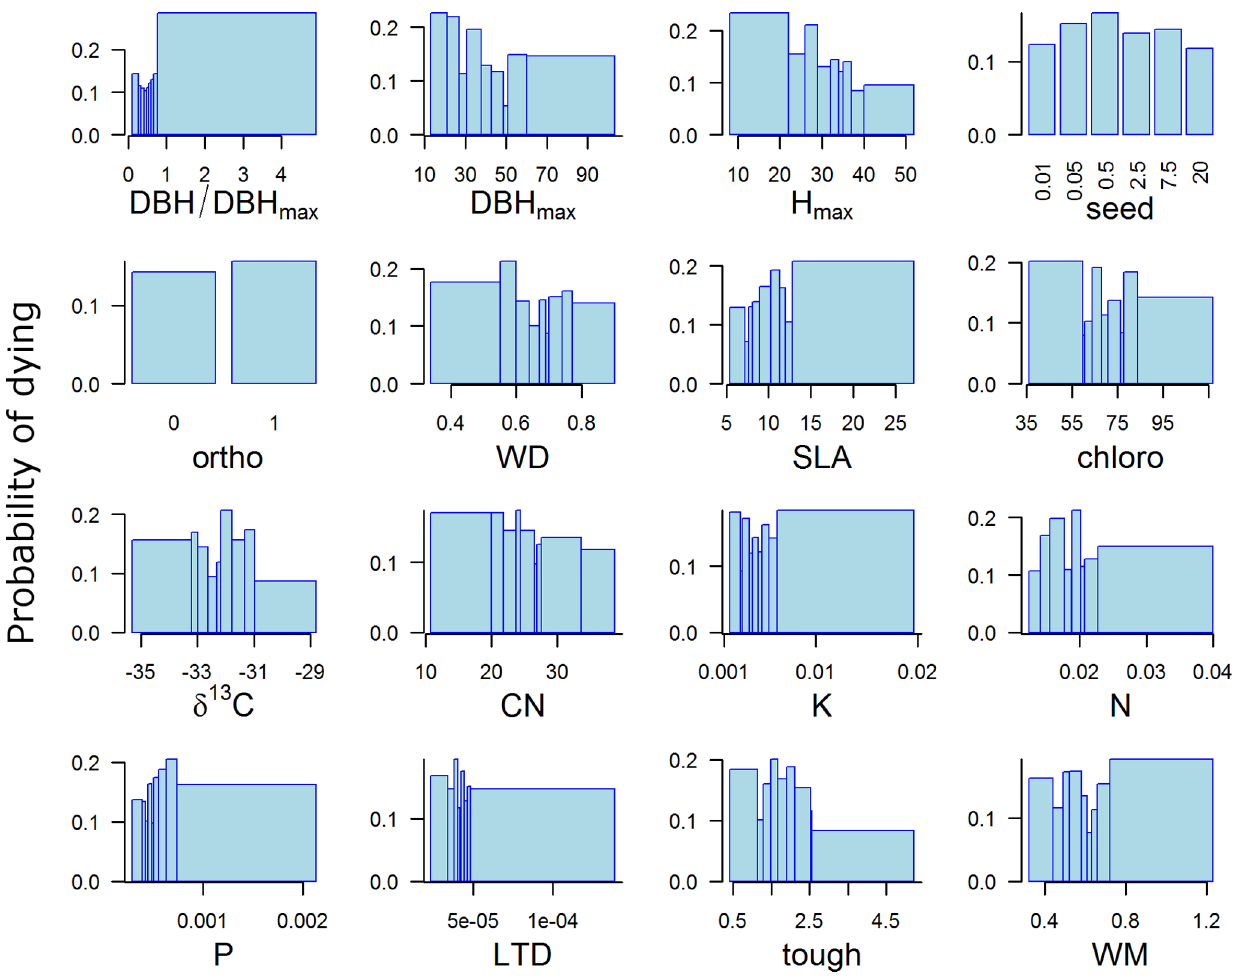
Figure 5. Effects of ontogenetic stage and functional traits on mortality rates. Mortality rates were computed for each class of tree based on distribution deciles and plotted in the form of a histogram. In most cases, trait values are not evenly distributed, and this explains why the size of the bins is not regular. On the top-left histogram, we can see the U-shaped pattern for the ontogenetic variable.